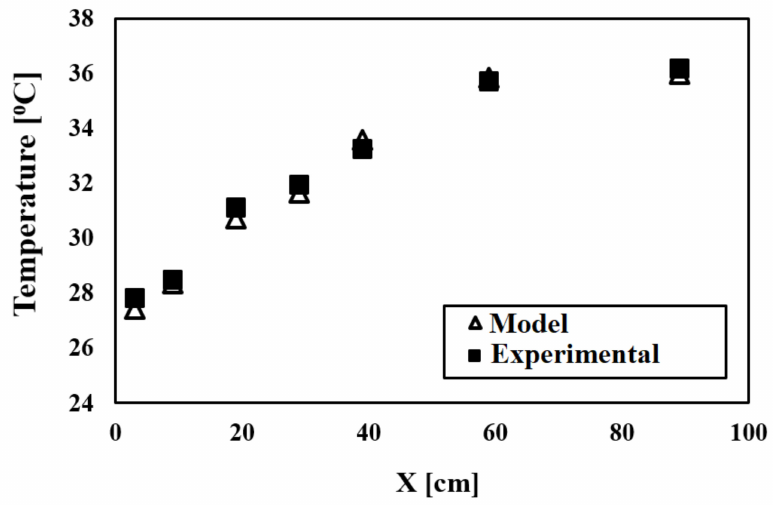
Figure 13. The results of the validation analysis with the present experimental